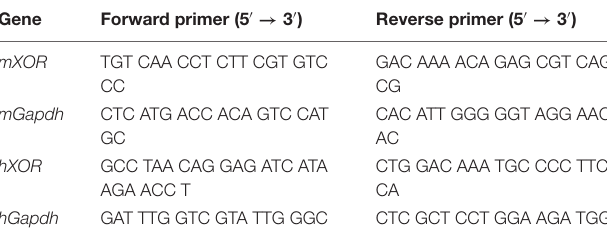
TABLE 1 | Murine and human gene specific primers for